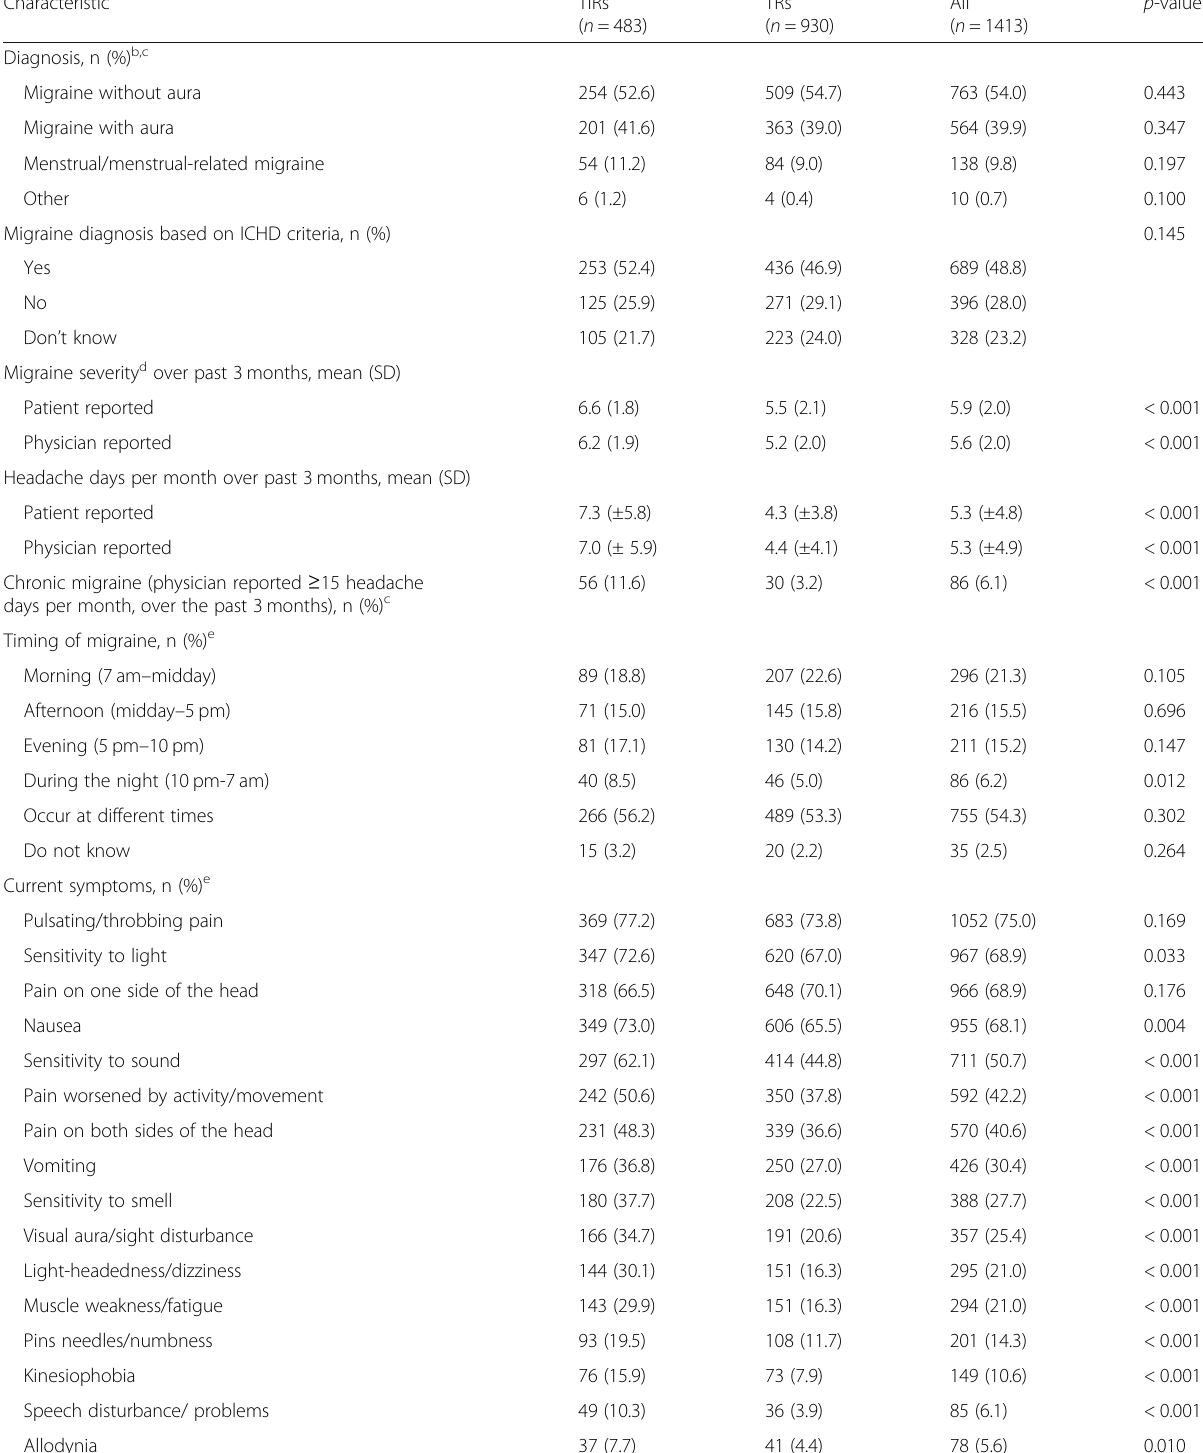
a P -values from test of two group difference: t-test for continuous variables and chi-square for categorical variables. b Physicians could attribute more than one diagnosis to each patient if applicable. c Physician reported. d Reported severity using scale from 1 (very mild) to 10 (very severe). e Patient reported SD=standard deviation; TIR=triptan insufficient responder; TR=triptan